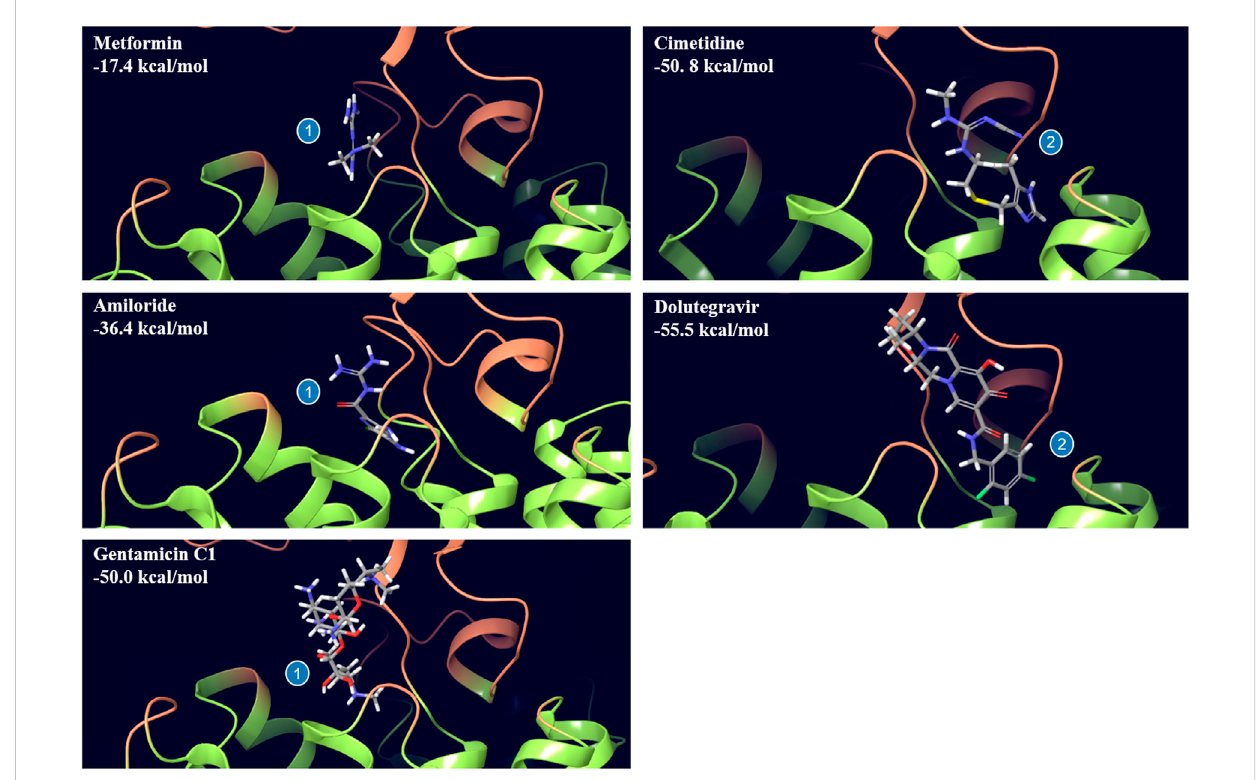
FIGURE 4 Binding pose of selected drugs to distinct binding sites of OCT2 as obtained from docking. Metformin, amiloride and gentamycin C1 bind to site 1, whereas cimetidine and dolutegravir bind to site 2. The estimated binding free energy of each pose is indicated in each